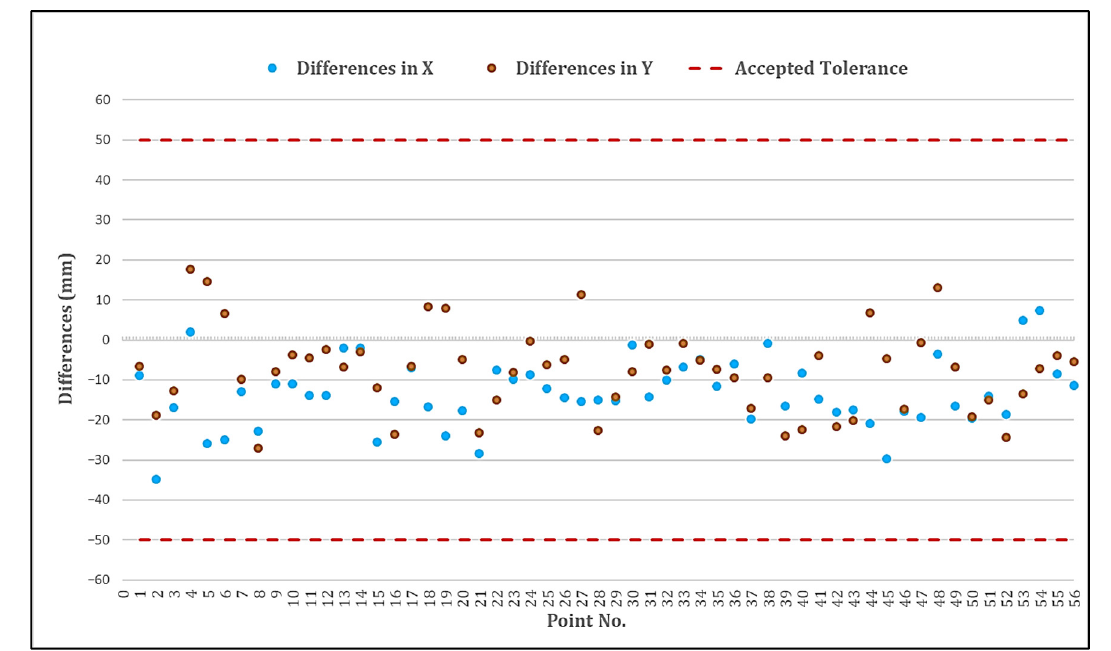
Figure 7. UAV fight plan images above the simulated scene of the pier caps.